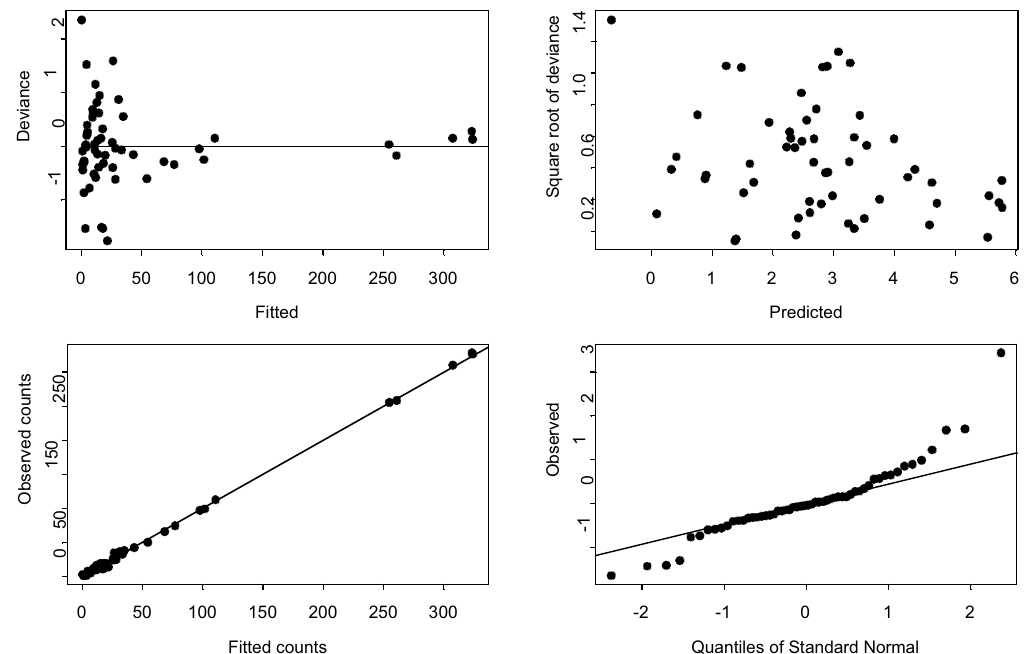
Fig. 2. Analysis of residuals. From top left to bottom right, several types of residuals are plotted: difference of deviance values specific for each cell against fitted values, a transformation of them (square root of the absolute value) vs. predicted values, observed against fitted frequencies, quantile-quantile plot of Pearson